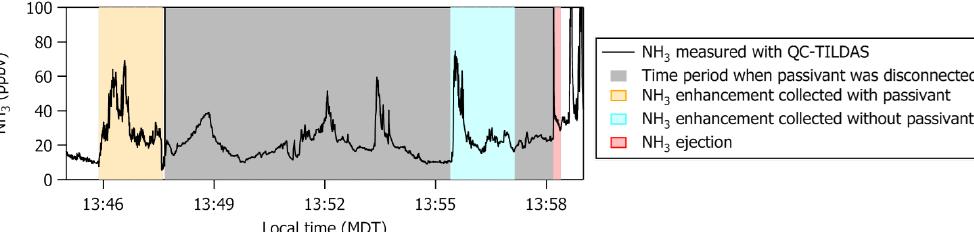
Figure 9. Time series of 1Hz NH 3 mixing ratios measured with a clean QC-TILDAS during the test flight on 13 July 2018. Portions of the flight when the QC-TILDAS was passivated (at 13:46MDT) and non-passivated (at 13:58MDT) are highlighted by colored shaded areas in the time series. Passivant was disconnected from the instrument system between 13:47 and 13:58MDT (as indicated by the gray shaded area); NH 3 ejection is observed when passivant is re-added to the system (red shaded